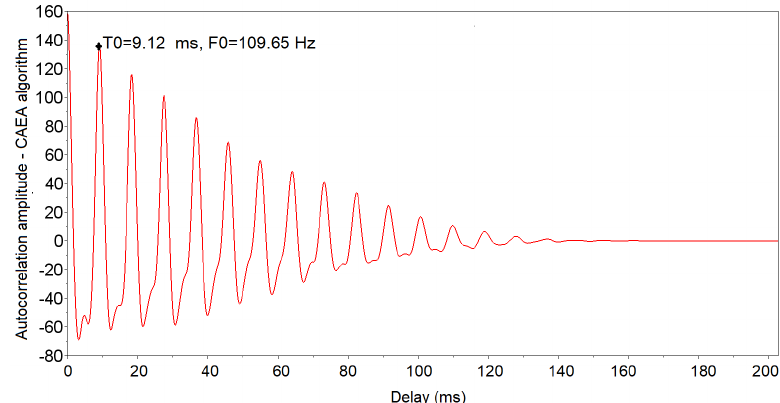
Figure 17. Results of the CAEA algorithm (autocorrelation method) graph of the A. fraterculus passing event of the standard group.